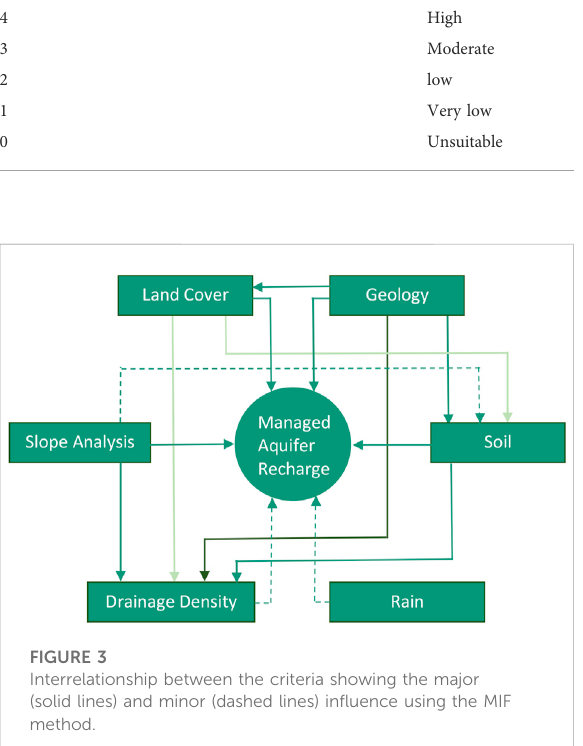
FIGURE 3 Interrelationship between the criteria showing the major (solid lines) and minor (dashed lines) in fl uence using the MIF